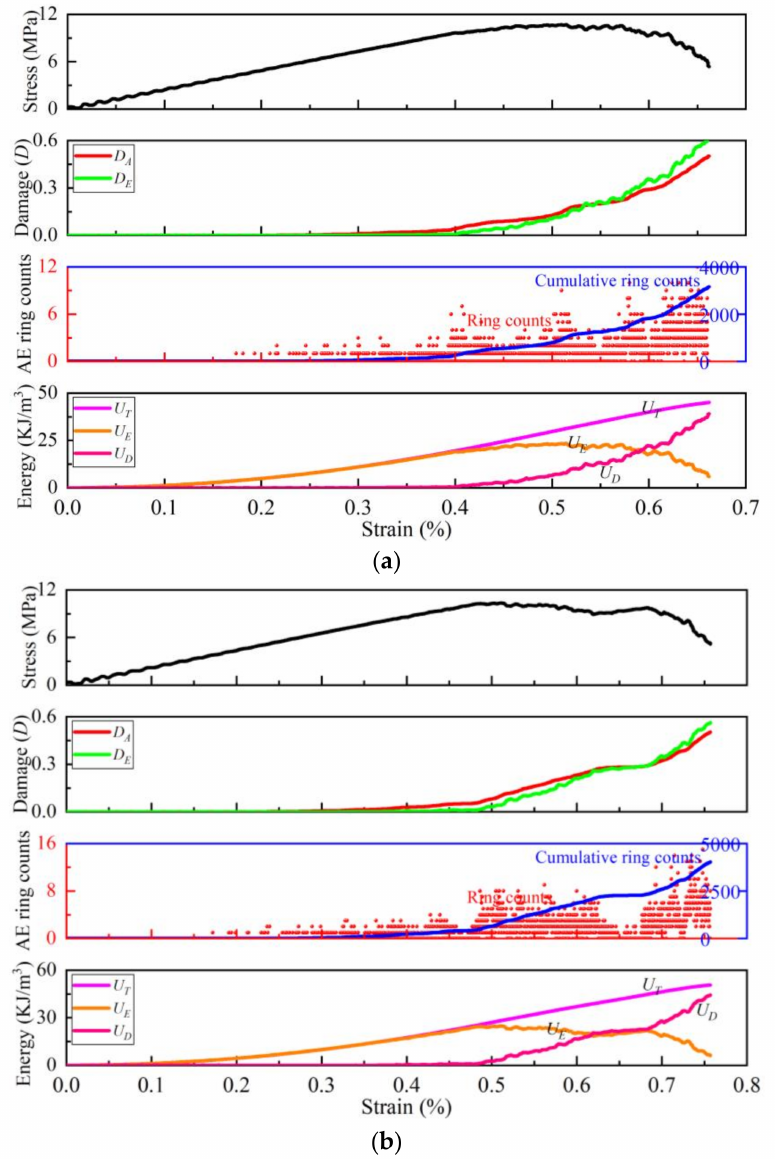
Figure 17. The stress–damage–AE–energy dissipation composite diagram: ( a ) RCF4 sample; ( b ) RCF5